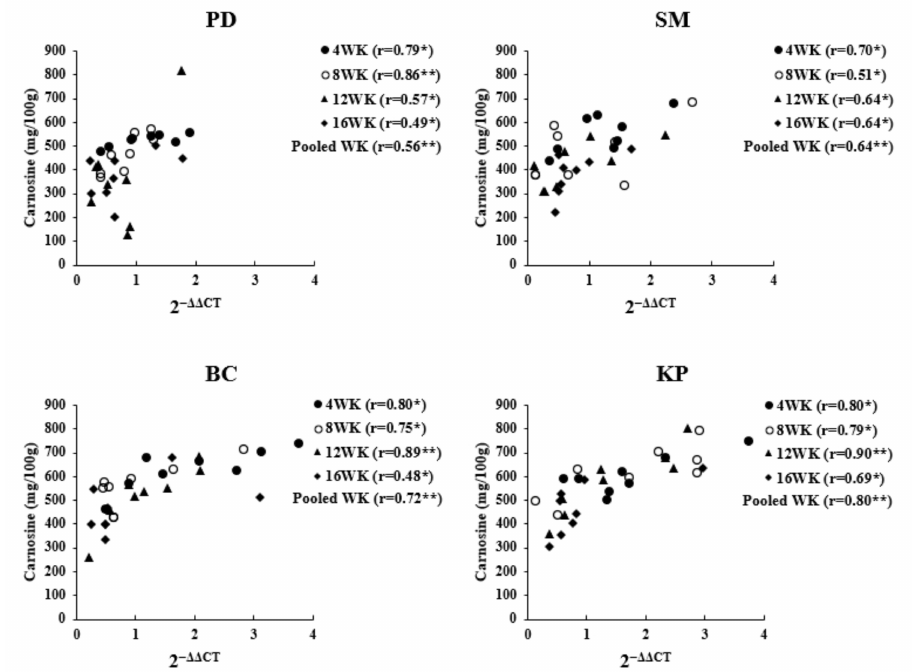
Figure 5. Correlation between carnosine content and expression level of CARNS1 . PD = Pradu Hang Dam breed (Thai native chicken); SM = Sri Mok breed (crossbred between BC and PD); BC = Black-Chinese breed (black-bone chicken); KP = KU-Phuparn breed (black-bone chicken); 4 WK = 4 weeks of age; 8 WK = 8 weeks of age; 12 WK = 12 weeks of age; 16 WK = 16 weeks of age; r = correlation coefficient: * p < 0.05, ** p <